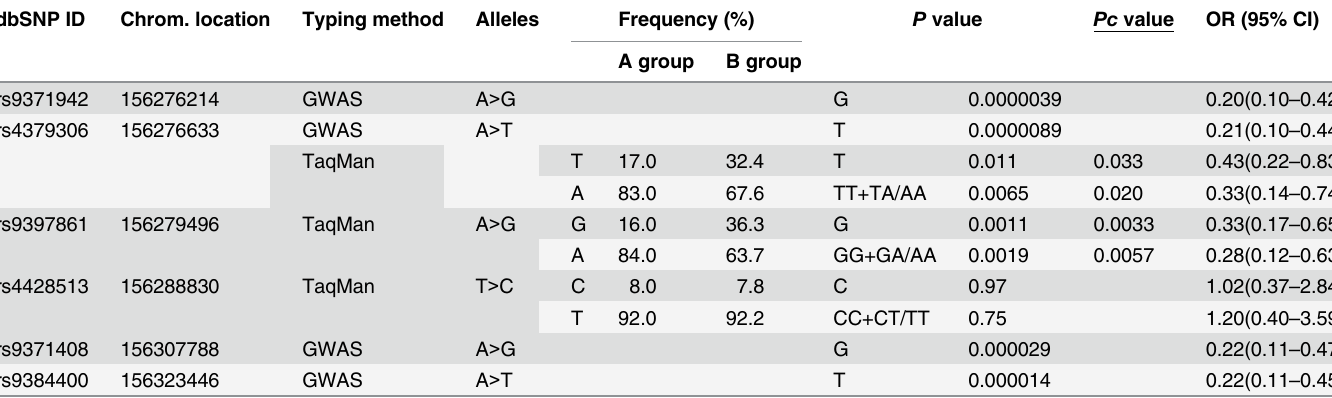
Table 5. Association analysis of single nucleotide polymorphisms in the LOC101928923 gene. dbSNP ID Chrom. location